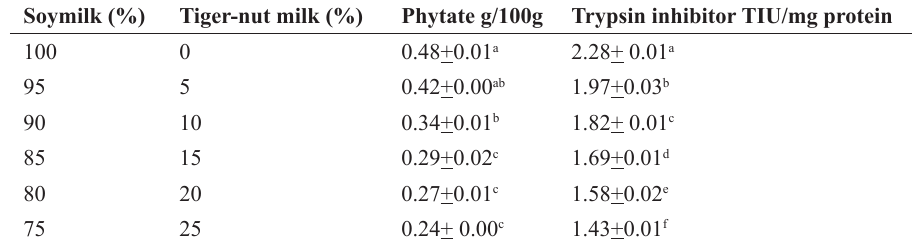
Table 4: Anti-nutrient composition of soy/soy-tiger-nut blend. Soymilk (%)